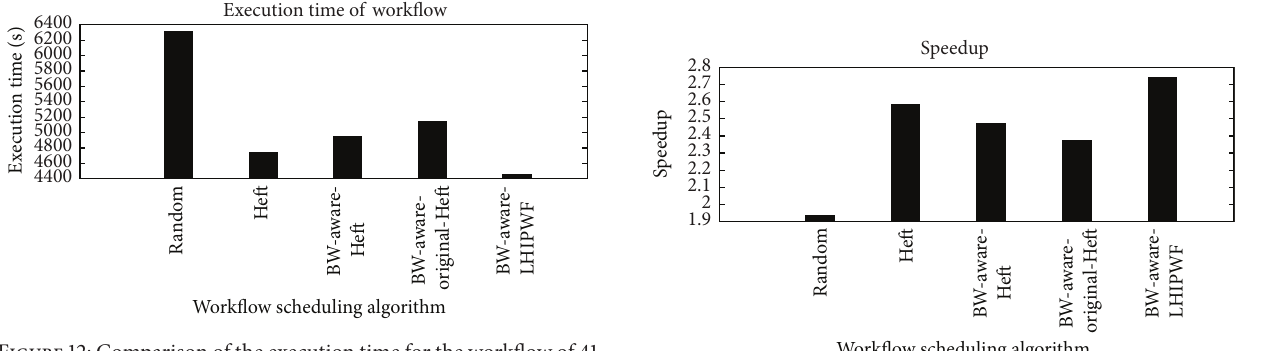
Figure 12: Comparison of the execution time for the workflow of 41 tasks with small data communication.